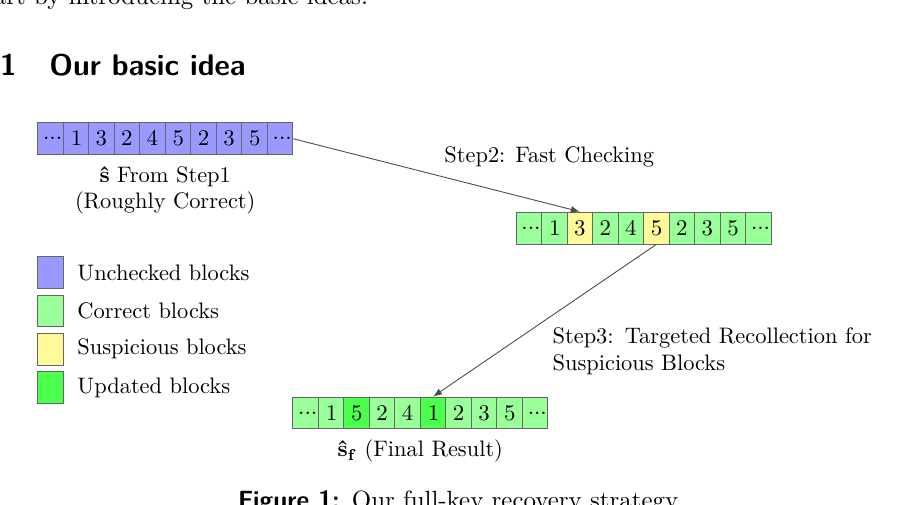
Figure 1: Our full-key recovery